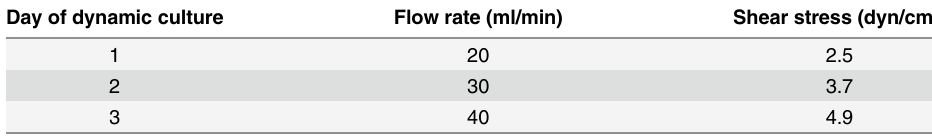
Table 1. Flow rates generated in the ENDOXY during dynamic cell